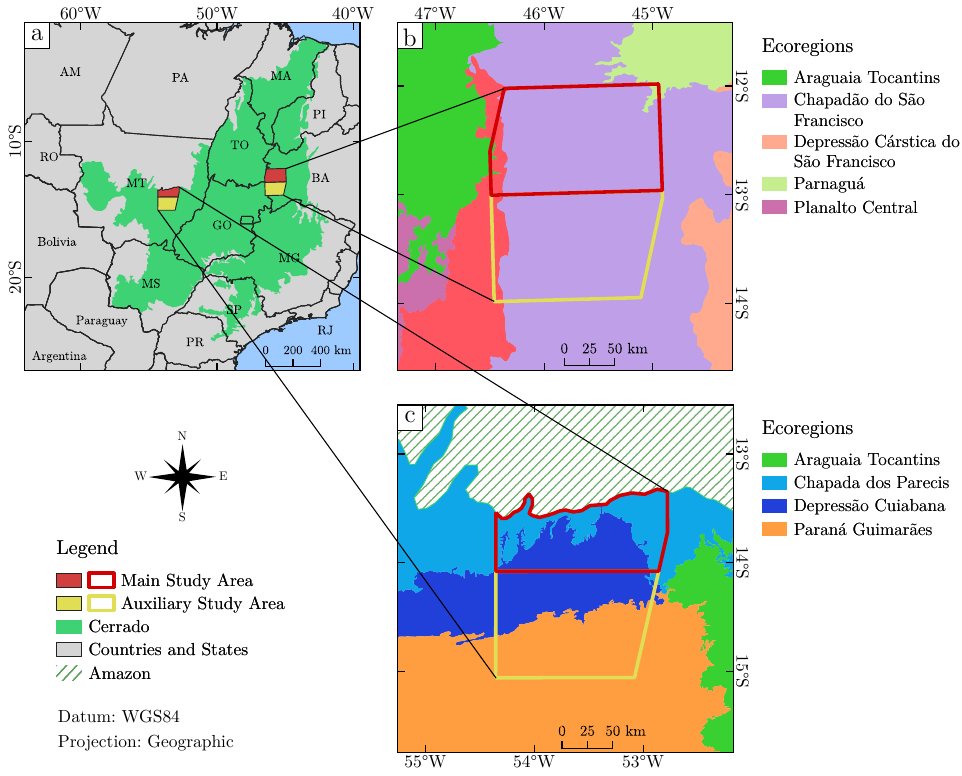
Figure 1. ( a ) Study area localization. ( b ) Bahia and ( c ) Mato Grosso. Ecoregions source: